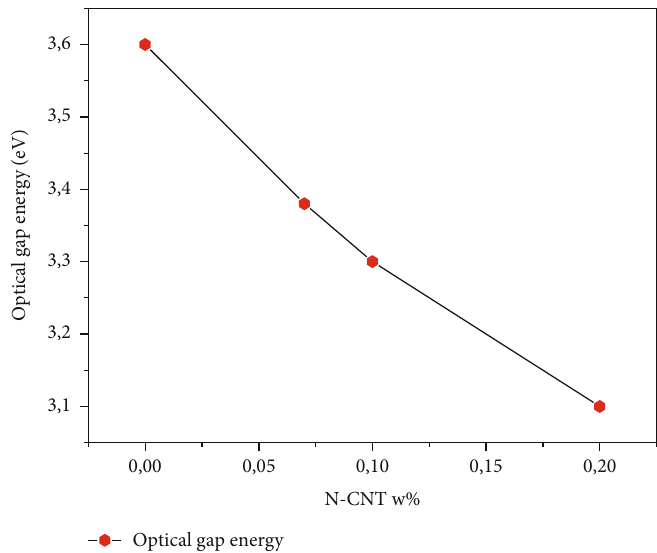
Figure 3: Variation of optical gap of epoxy/silicone nanocomposite fi lms versus N-CNT wt% loaded.